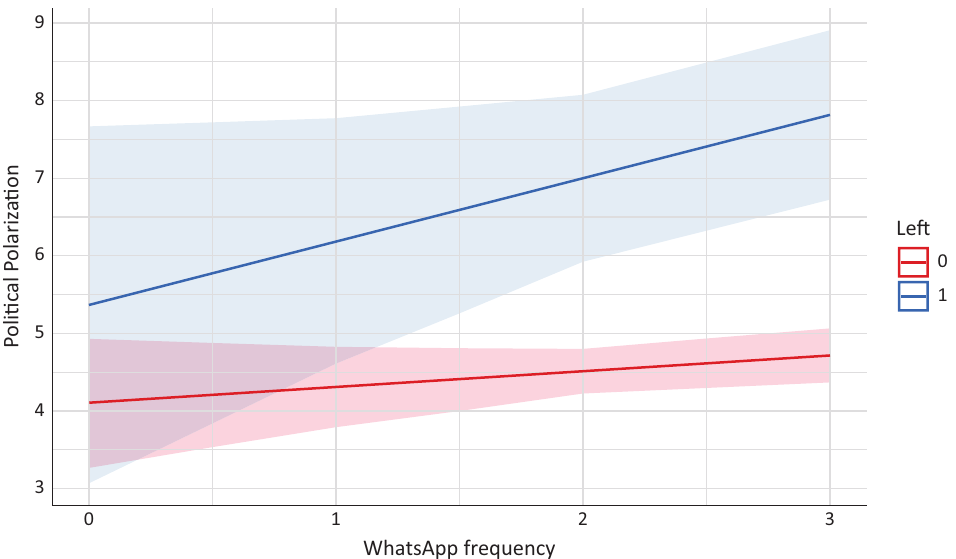
Figure 5. Predicted values of non‐conventional political participation in Colombia according to WhatsApp frequency and political position